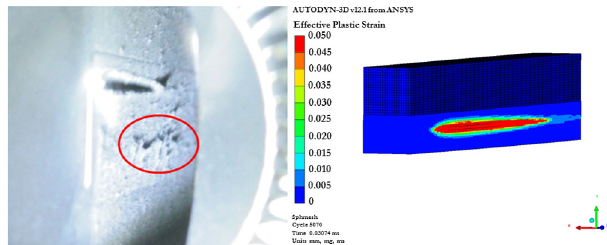
FIG. 27. Qualitative numerical benchmarking of the damage generated on first Inermet 180 jaw block by Test 2 beam impact. Note that the impacted zone is covered by particles from the opposite jaw produced during Test 3.